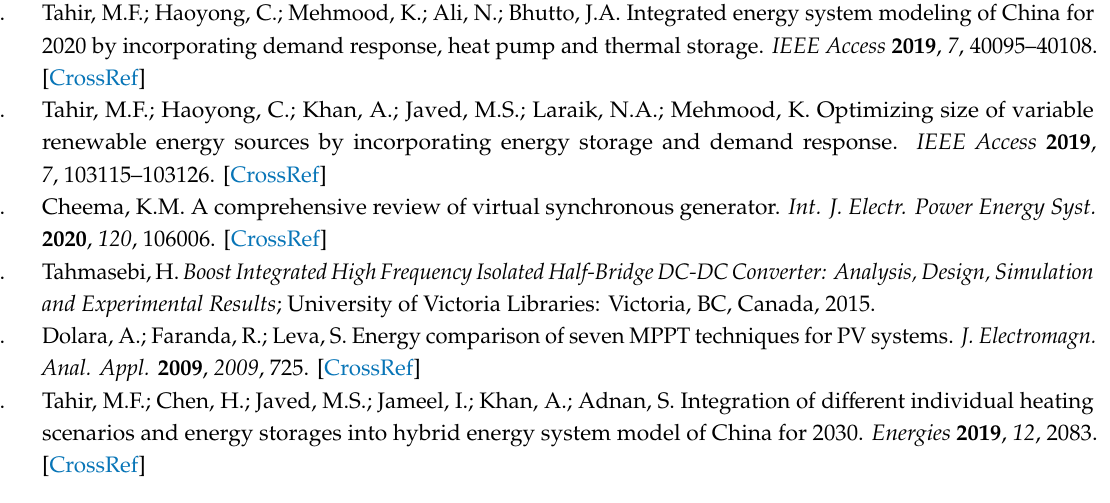
Table 6. Comparative analysis of fuzzy logic based MPPT. THD, total harmonic distortion.